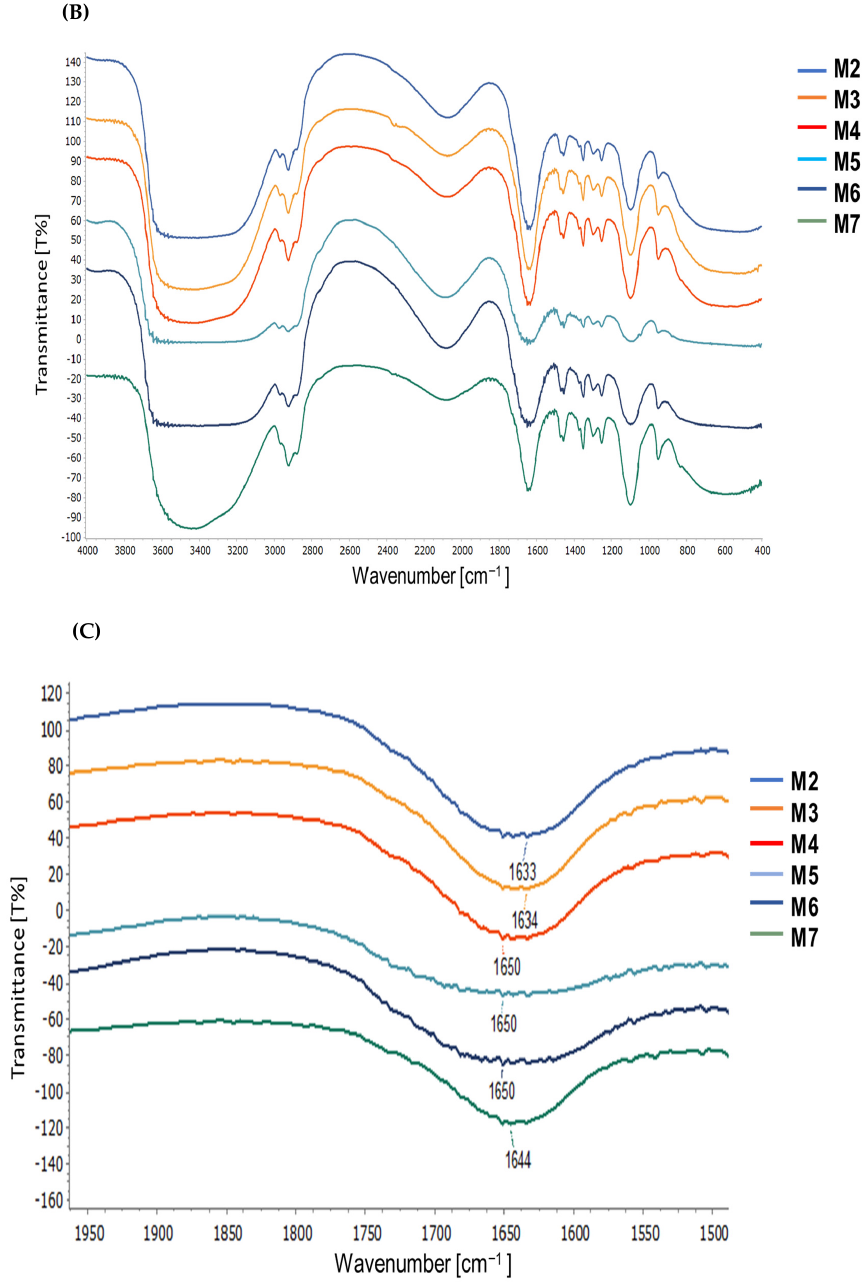
Figure 3. FTIR spectra of ( A ) F127: Pluronic ® F127, F68: Kolliphor ® P188, PRD: prednisolone, and PM: physical mixture, ( B ) M 2-7 microgels with shifted carbonyl stretching peak, and ( C ) shifted carbonyl stretching peaks in the M 2-7 microgels.